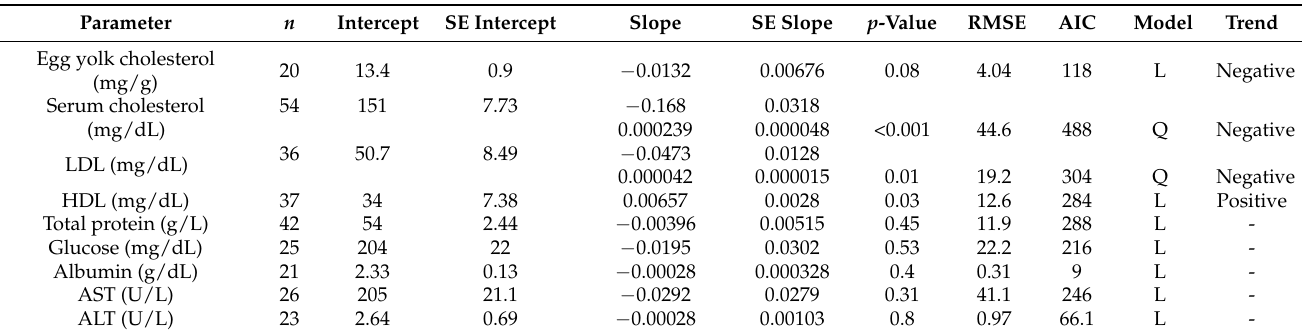
Table 4. Regression equations for the impact of phytogenic extract levels on egg yolk cholesterol and blood parameters of laying